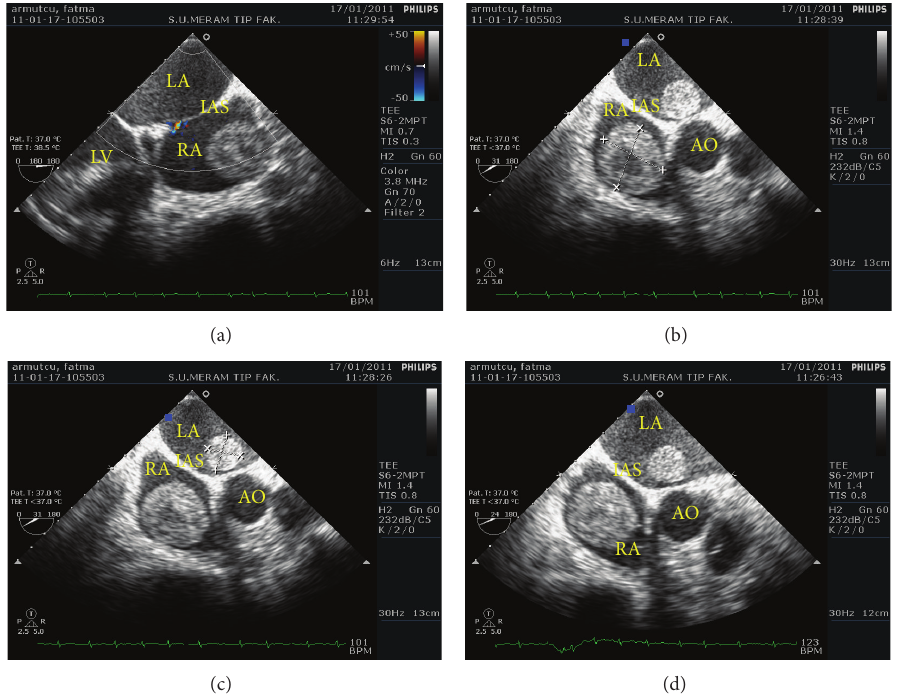
Figure 4: Transesophageal echocardiography demonstrates two mobile masses with biatrial cardiac metastases of malignant melanomas in uterine cervix, one attached to free wall (29 × 21mm) in right atrium and the other attached to interatrial septum (20 × 17 mm) in the